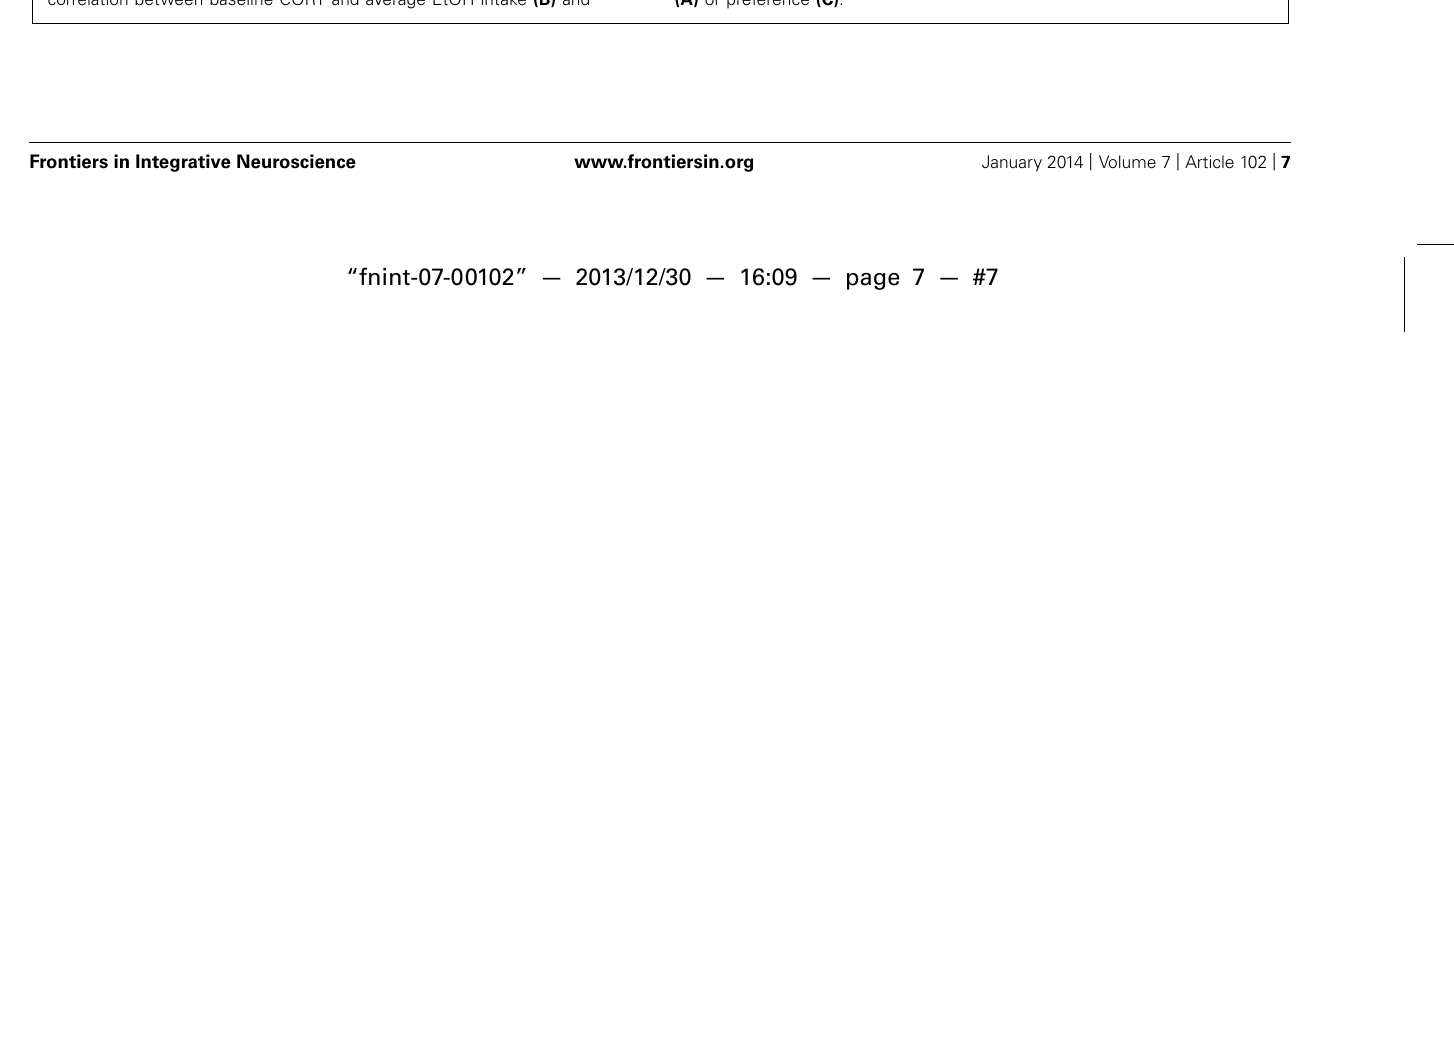
baseline CORT and average EtOH preference (D) . Conversely, GH rats’ baseline CORT was not significantly correlated with average EtOH intake (A) or preference (C)